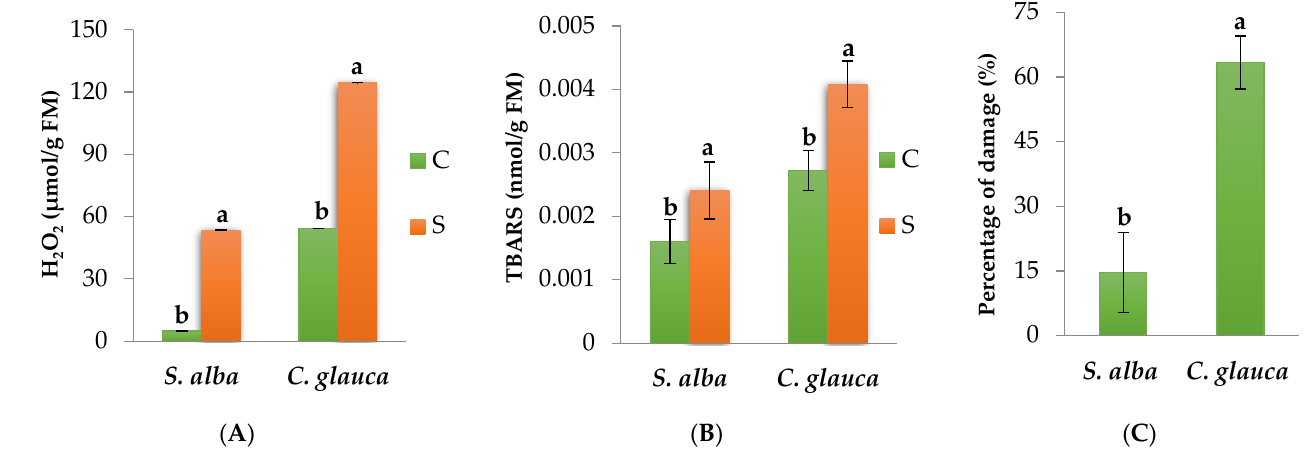
Figure 5. Variation in the concentrations of hydrogen peroxide H 2 O 2 ( A ), thiobarbituric acid reactive substances (TBARSs) ( B ) and percentage damage to membrane structures ( C ) in S. alba and C. glauca treated with IWW (S, stress) or with tap water (C, control), (n = 5; mean ± SD). Different letters above the means indicate a significant difference at p < 0.05 according to SNK tests.